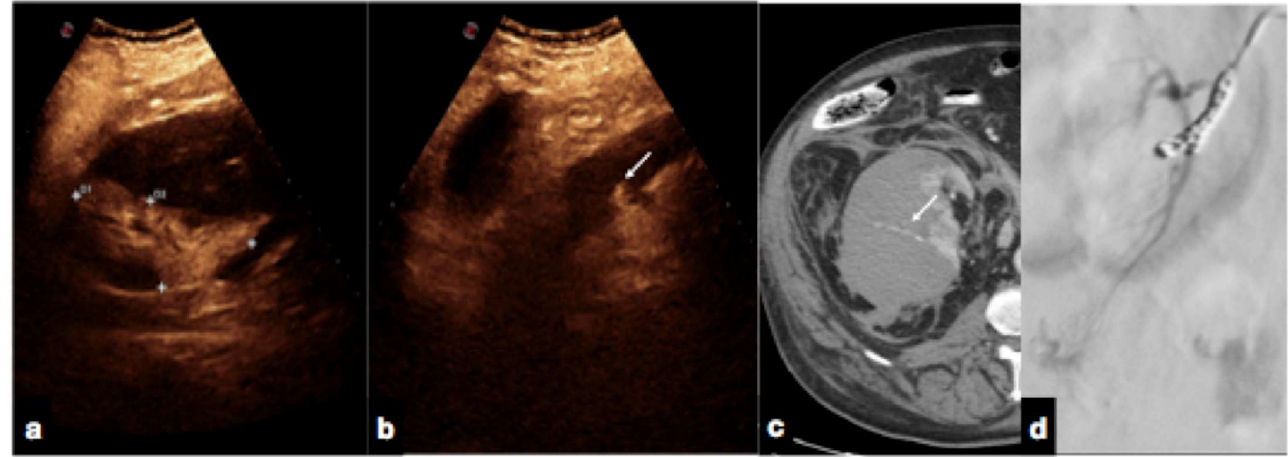
Figure 17. Follow-up CEUS of a 52−year-old blunt trauma patient with high-grade right kidney injury and extensive ischemia complication. Venous ( a ) phase CEUS examination shows multiple kidney lacerations with extensive ischemia complication and a small amount of perfused renal (caliper). At the same venous phase ( b ), CEUS active venous hemorrhage is well appreciated (arrow) confirmed at contrast-enhanced venous phase CT scan ( c, arrow) and subsequent angiography ( d ) .